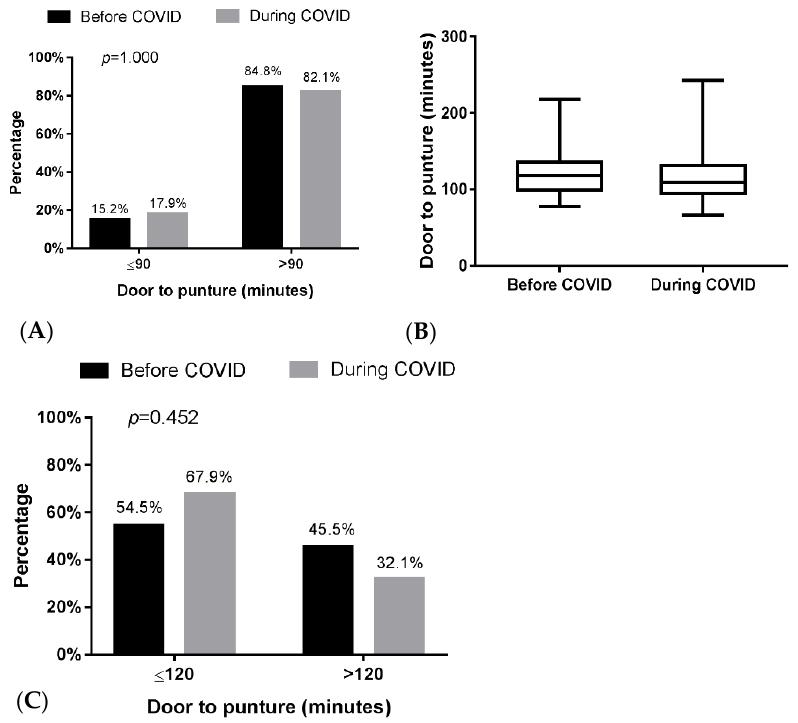
Figure 3. Comparison of door-to-puncture times between the during and pre-groups. ( A ) The door-to-puncture times compared. ( B ) The door-to-puncture time of 90 min compared. ( C ) The door-to-puncture time of 120 min compared.